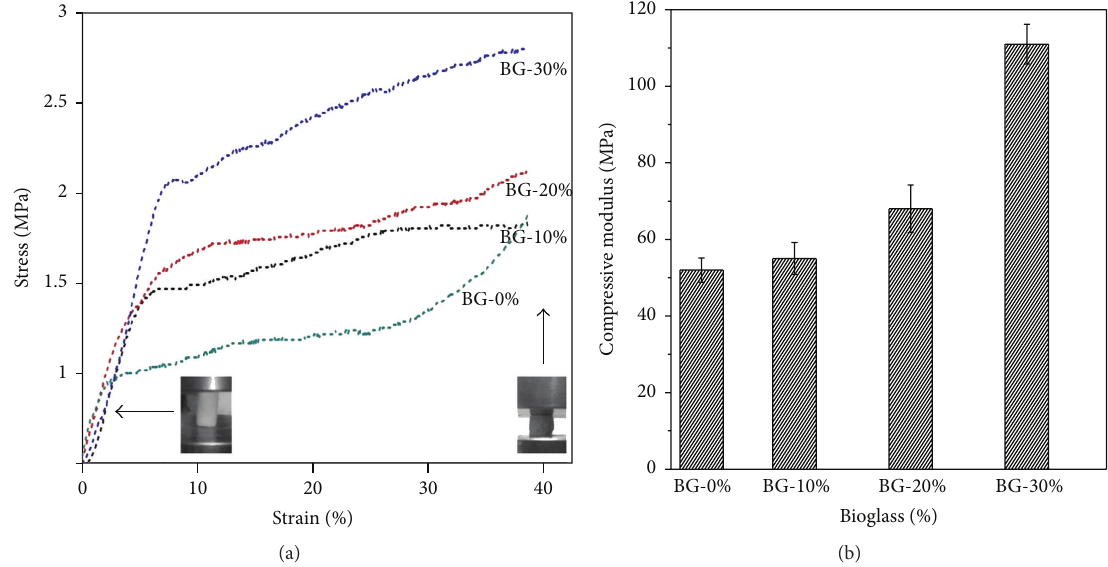
Figure 9: Mechanical properties of GCB scaffolds prepared at different bioglass concentrations and acquired in (a) compression test and (b) Young’s modulus. The corresponding porosity and moduli are shown in Table